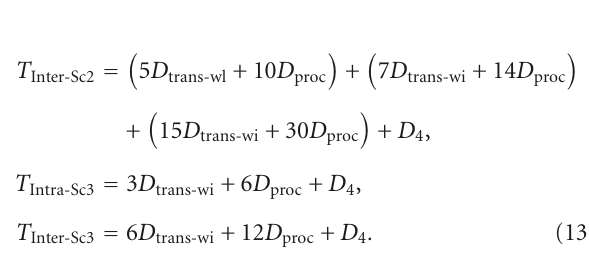
Figure 8: Authentication signaling cost for Sc1 and Sc2 for di ff erent n pre